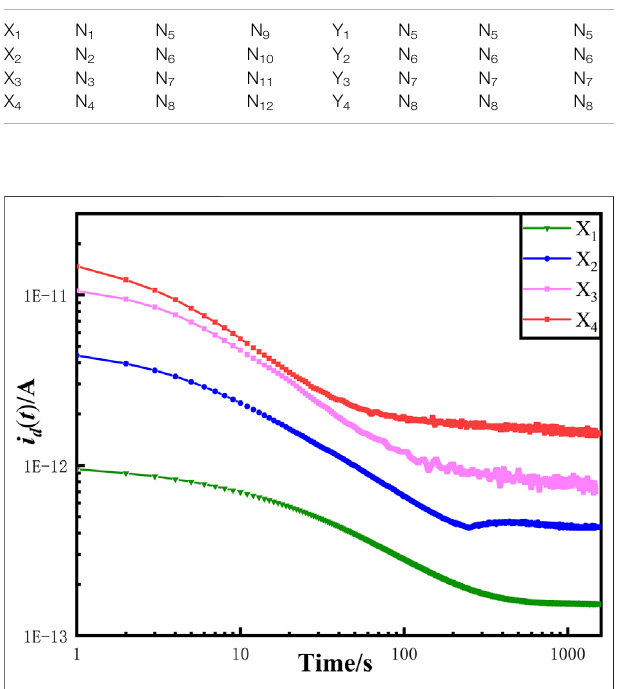
FIGURE 3 | PDC curve under different aging